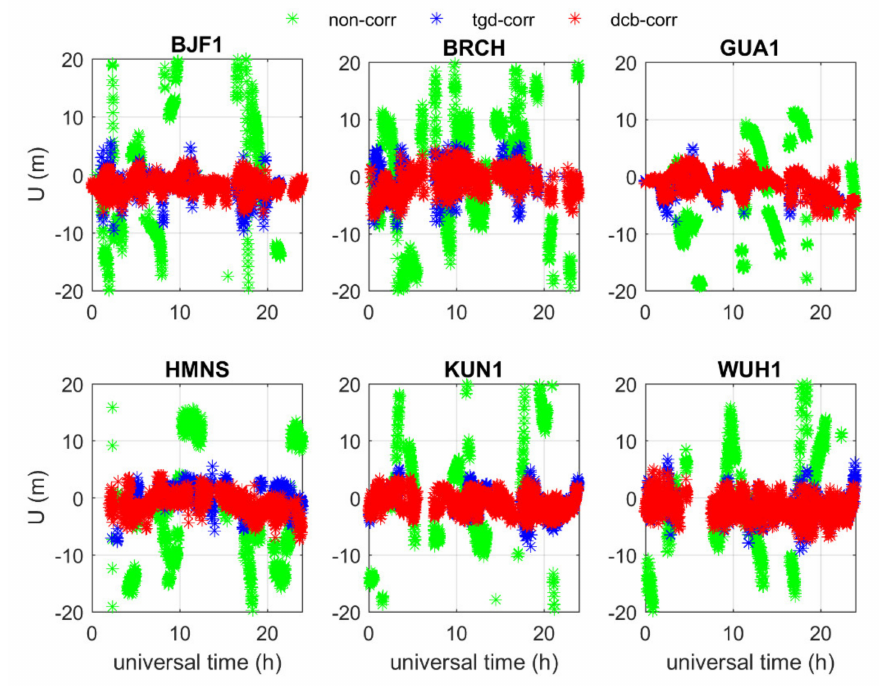
Figure 8. Vertical positioning error scatters with and without TGD or DCB correction of B1C SPP at six